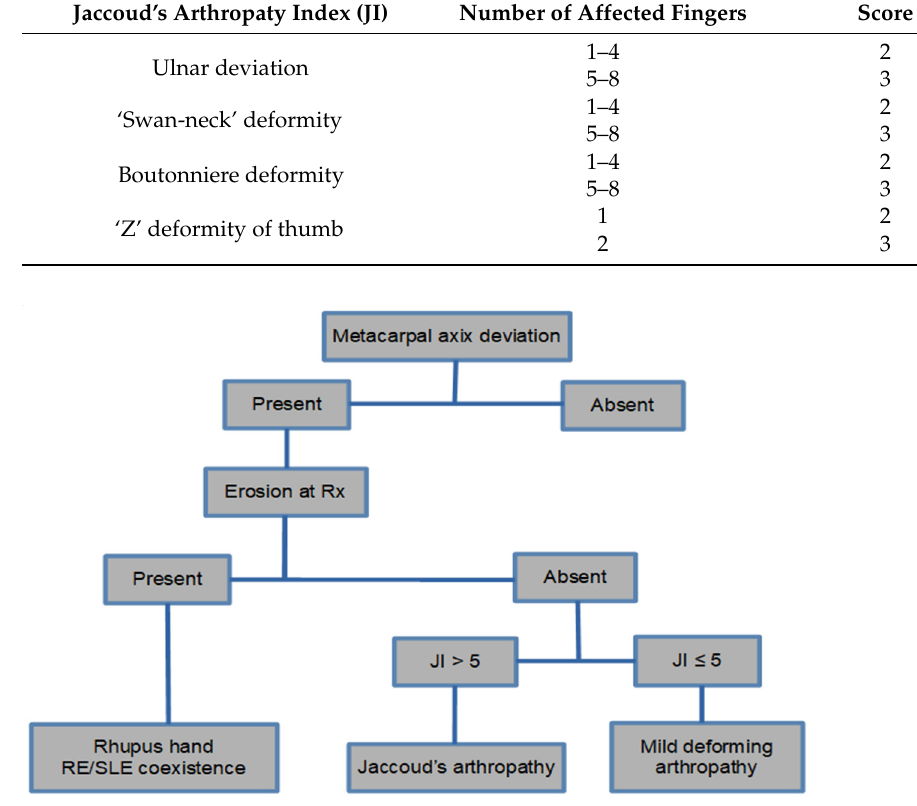
Figure 3. Algorithm with the forms of classification of joint involvement in SLE [13]. Table 1. Diagnostic criteria according to Spronk. Jaccoud’s arthropaty is considered present if the scoring (Jaccoud’s index; JI) achieved is >5 [6]. Table 2. Imaging findings in three types of systemic lupus erythematosus on radiographs, ultrasound, and magnetic resonance